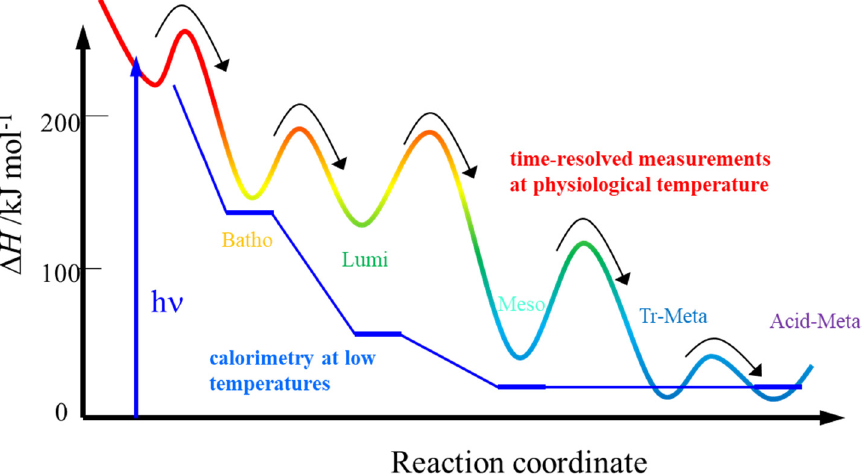
Figure 3. Enthalpy changes along reaction coordinates of octopus rhodopsin at 297 K. For comparison, enthalpy changes for trapped intermediates at low temperatures are also shown in blue.